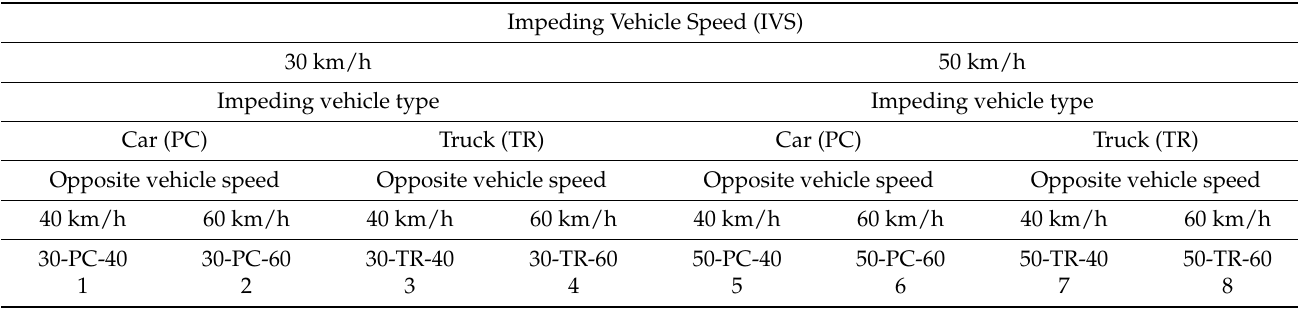
Figure 4. Layout of the driving simulator. Table 1. Variables within the experimental design